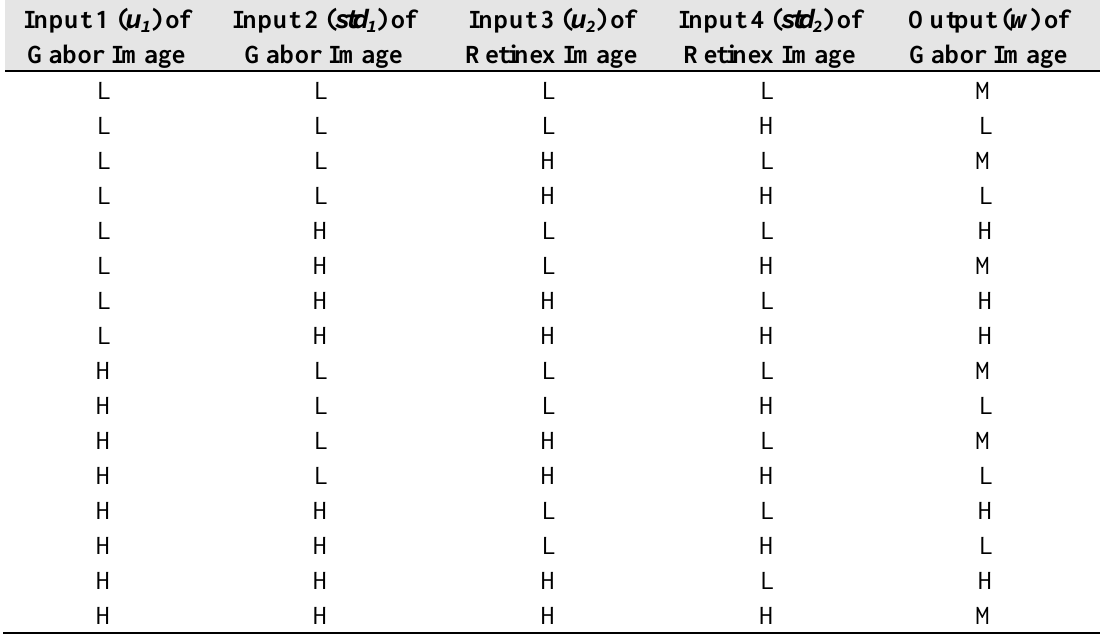
Table 2. Fuzzy rules based on the characteristics of the Gabor and Retinex filtered images. Input 1 ( u ) of 1